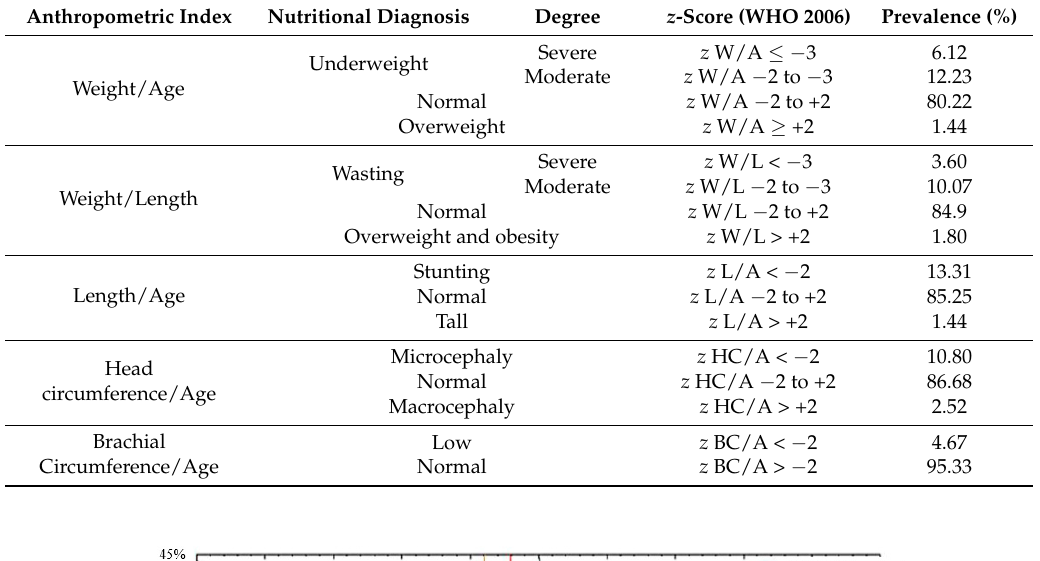
Table 2. Nutritional status in 278 infants seen at the Klinik Saint Espri Health Center, Port au Prince, Haiti (August to September 2014).